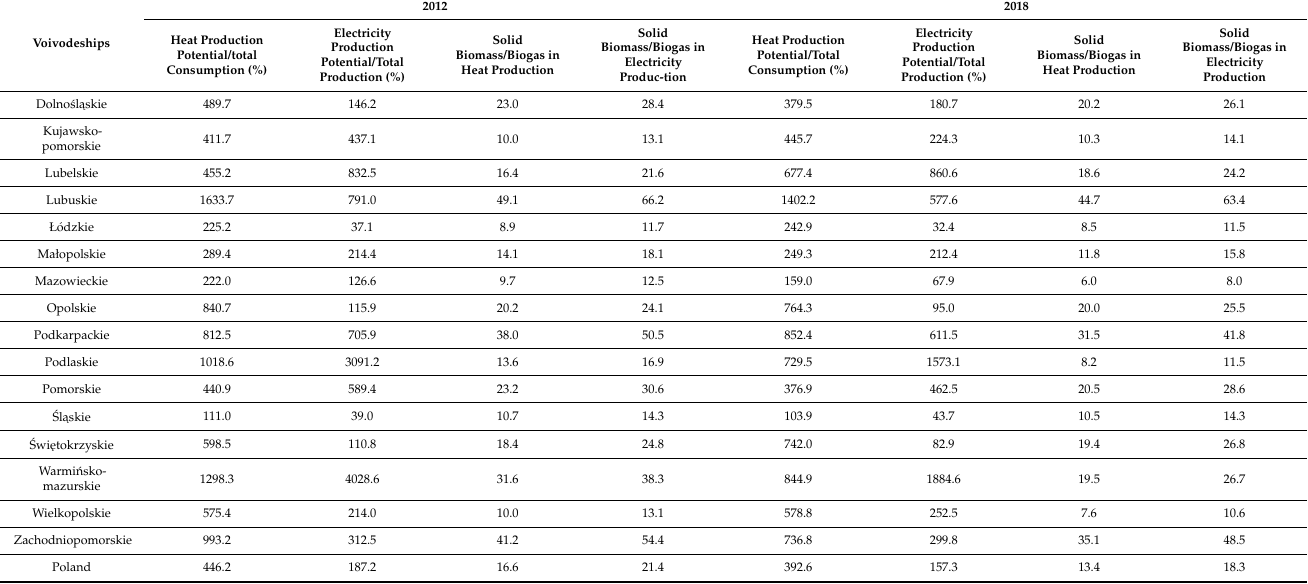
Table 2. Comparison of the total electricity and heat production potential in 2012 and